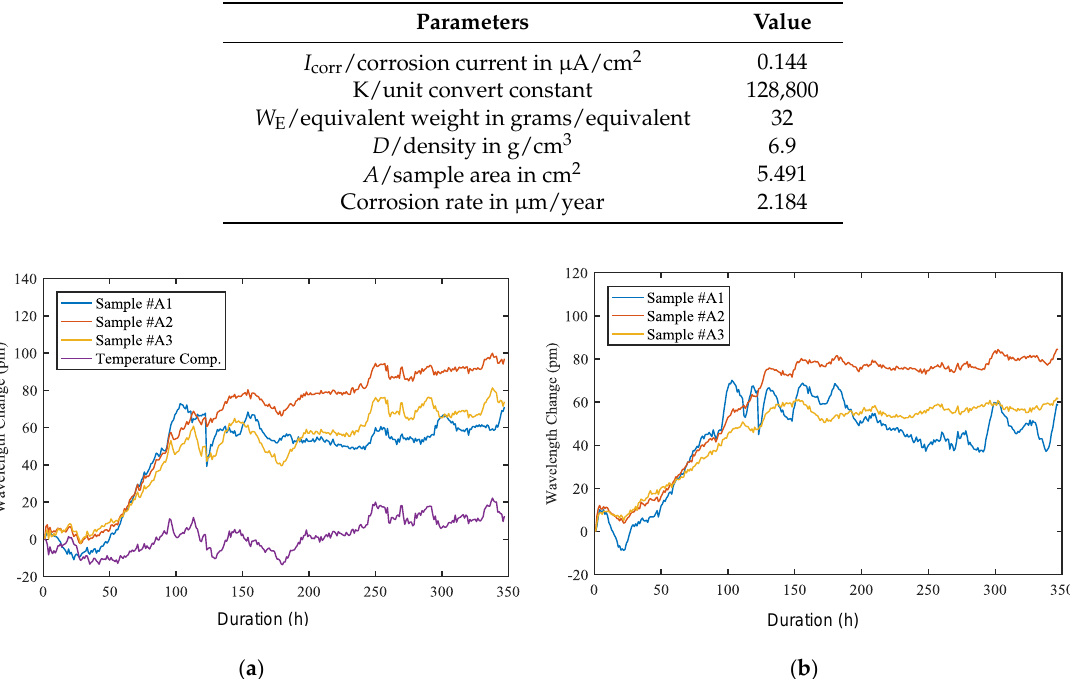
Figure 11. Bragg wavelength of embedded FBG sensors with wire arc sprayed Al-Zn coating vs. time ( a ) before temperature compensation and ( b ) after temperature compensation.